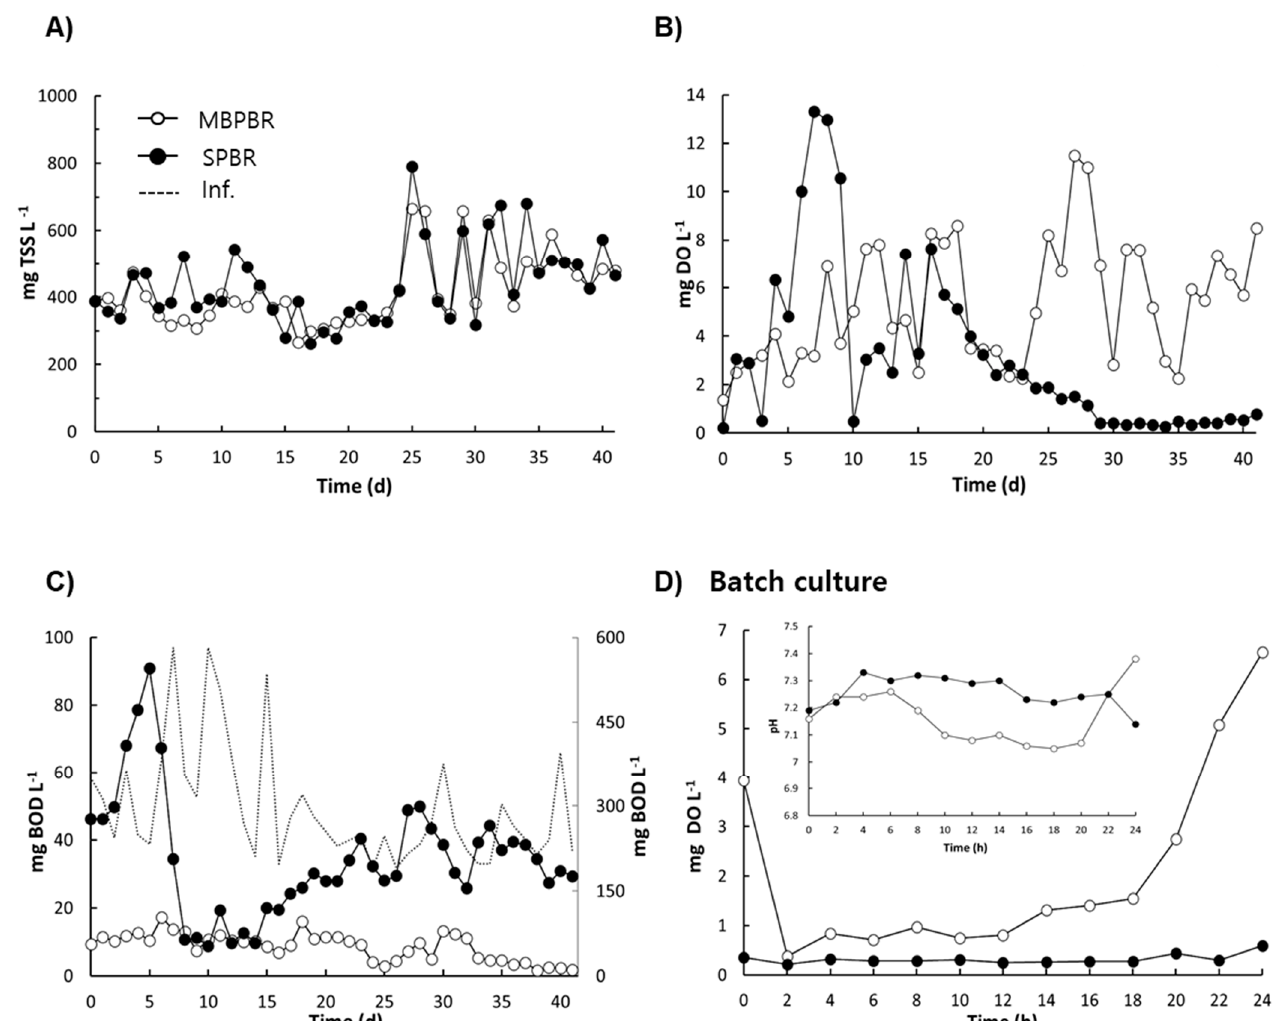
Figure 3. Daily variation in the effluent concentrations of suspended-growth biomass ( A ), dissolved oxygen (DO) ( B ), and biological oxygen demand (BOD) ( C ) from photobioreactors (PBRs) for the operating days. Temporal variation in the effluent concentration of DO and pH from PBRs for 24 h ( D ). MBPBR and SPBR represent the PBR with a moving bed and the PBR without a moving bed at light intensities of 500 µmol·m − 2 ·s − 1 , respectively. Both the MBPBR and SPBR were operated with a hydraulic retention time of 4 d. Measurements were conducted in triplicate and the mean values of the triplicates were plotted. Total Suspended Solid(TSS).